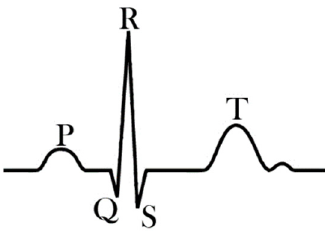
Figure 1. Typical features of an ECG signal. From Reference [18], originally published under a CC-BY